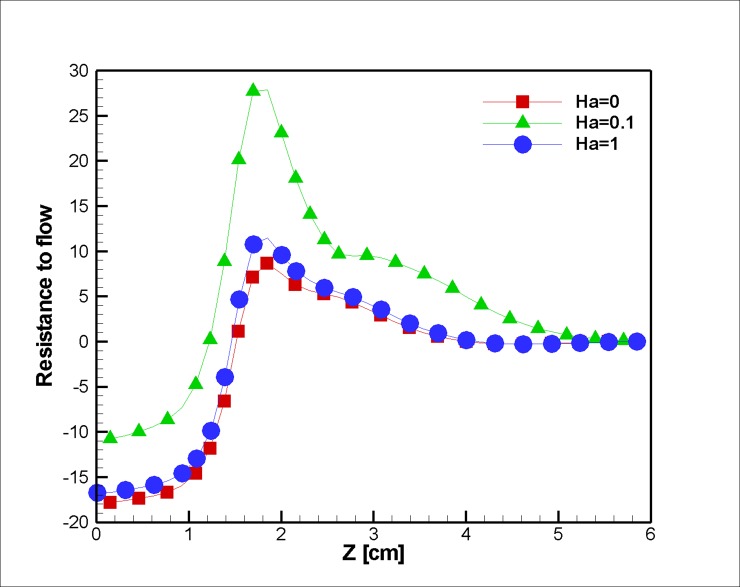
Resistance to the flow for five different stenosis blockage percentages over the midline (r = 1.25 mm) of the blocked vessel at the middle of the simulation, t = 0.5 s, Lvessel = 6 cm, Rvessel = 1 cm.